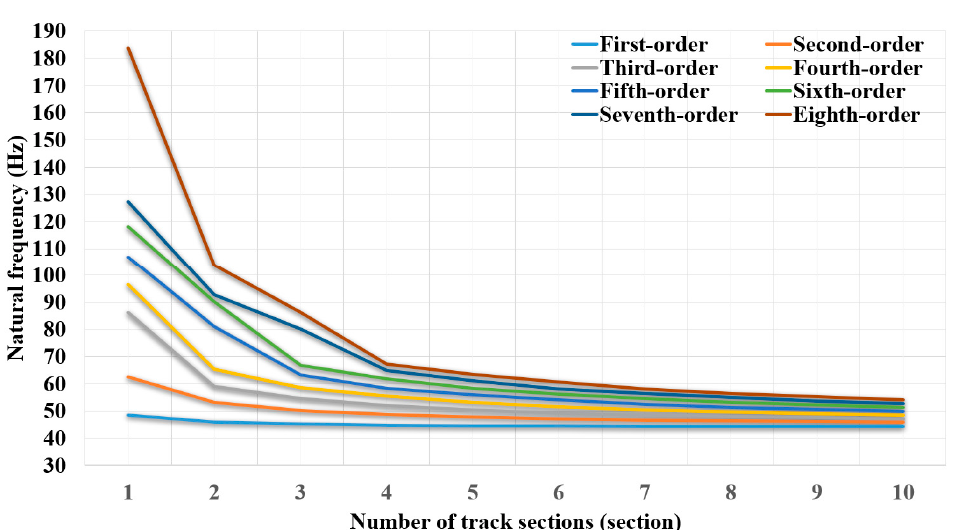
Figure 3. Natural frequency variation of orbits with different number of knots.